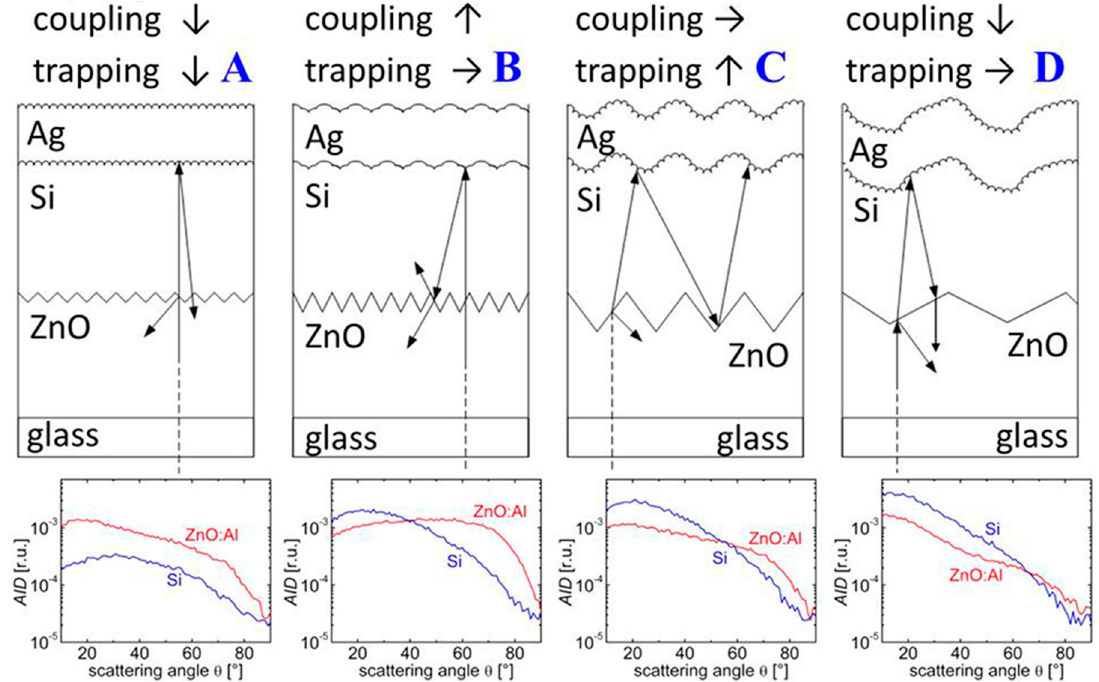
Figure 6. Schematic overview of different texture types and their effects on light-trapping and light-coupling. The angular resolved scattering measured at the ZnO:Al/air-interface (red lines) and at the silicon/air- interface (blue lines) is plotted in the graph below each schematic.